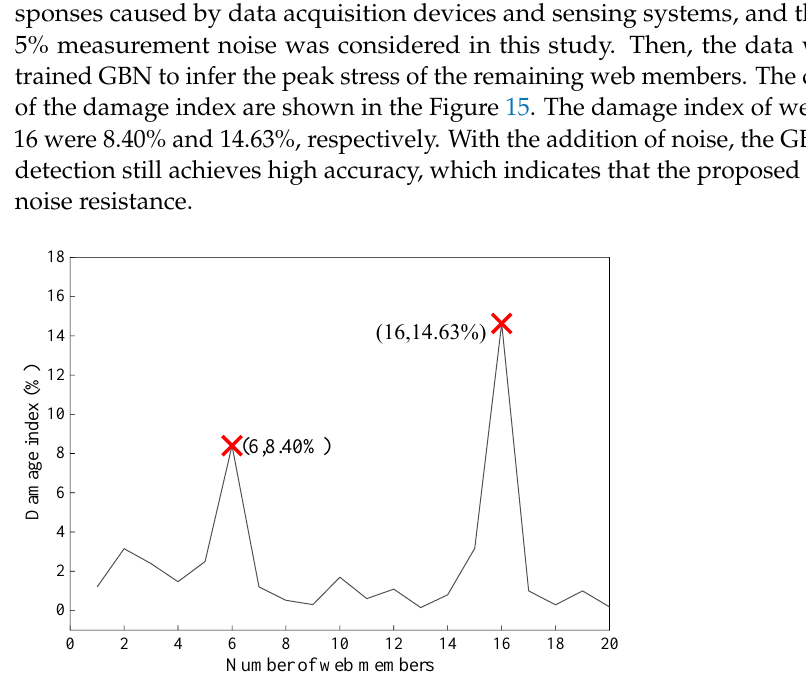
Figure 14. Multi-point damage detection results based on the vehicle loads without noise.